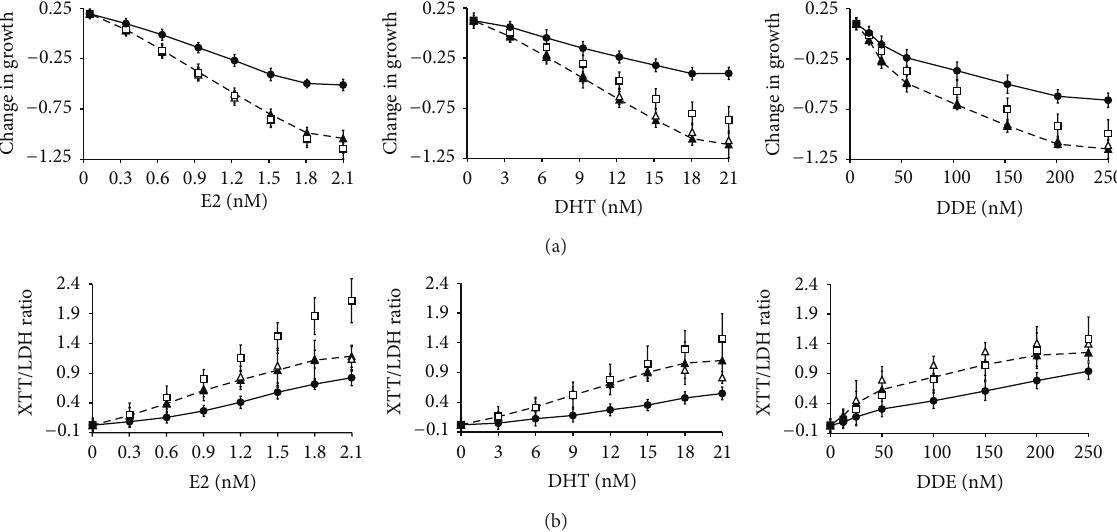
0.40.91.41.92.4 o t i r a H 0 0.3 0.6 0.9 1.2 1.5 1.8 2.1 Figure 2: Changes in growth of B-lymphocytes and their mitochondrial/cell ratio as a function of E2, DHT, and DDE concentrations. Cumulative sum plots of Figure 1 data were created showing the effects of the 3 effectors on the 4 cell types, AUT ( e ), Bro ( 󳵳 ), Sis ( 󳵻 ), and Con ( ◻ ). Solid line = AUT, broken line = Bro. Error bars are SEM. (a) shows changes in cellular growth as evidenced by LDH levels in the different cell populations when grown in the presence of the 3 effectors. (b) shows changes in the mitochondrial function per cell as evidenced by the XTT/LDH ratio. The starting concentration of zero nM represents the baseline LDH and XTT/LDH levels normalized to 0. The most significant difference between the AUT and Con cells in regard to growth suppression and mitochondrial function was seen in the presence of DHT. ASD: autism spectrum disorder; AUT: B cells from individual with ASD; Bro: B cells from brother of individual with ASD; Con: control B cells from individual with no personal or family history of ASD; DDE: dichlorodiphenyldichloroethylene; DHT: dihydrotestosterone; E2: estradiol; LDH: lactate dehydrogenase; SEM:standard errorofthemean; Sis: Bcells fromphenotypically normal sisterofindividual with ASD; XTT: 2,3-bis(2-methoxy-4-nitro-5-sulfophenyl)-2H-tetrazolium-5-carboxanilide; XTT/LDH: ratio of XTT/LDH indicative of mitochondrial function per